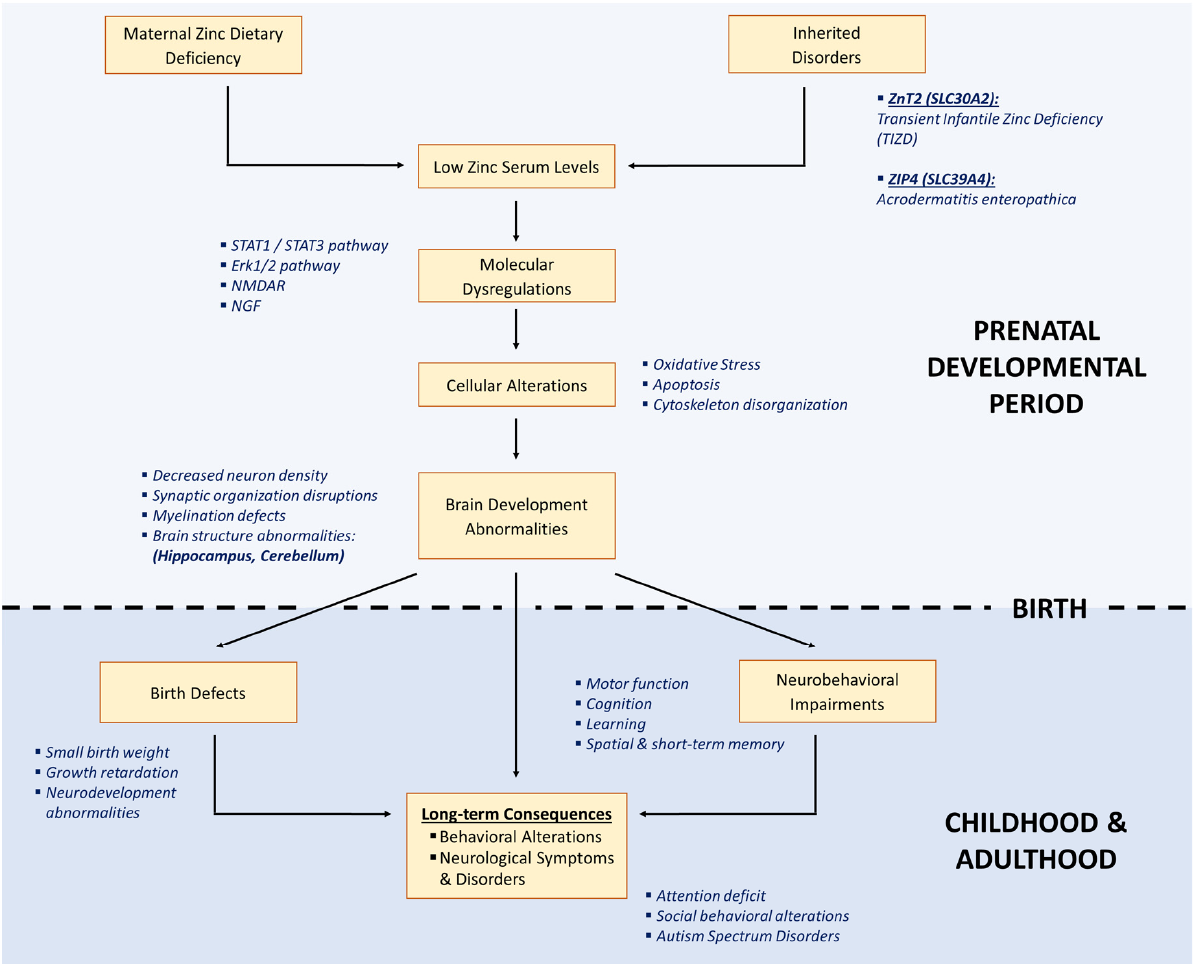
Figure 2. Long-term consequences of zinc deprivation during brain development. Dietary zinc is absorbed (uptake) in the small intestine (duodenum and jejunum) and about 60% and 30% will be stored in the bone and skeletal muscles, respectively. Liver and skin both represent about 5% of zinc storage in the body. The remaining is transported to other organs, such as the brain, the pancreas, the kidney, or the mammary gland through blood circulation, constituting only about 0.1% of the